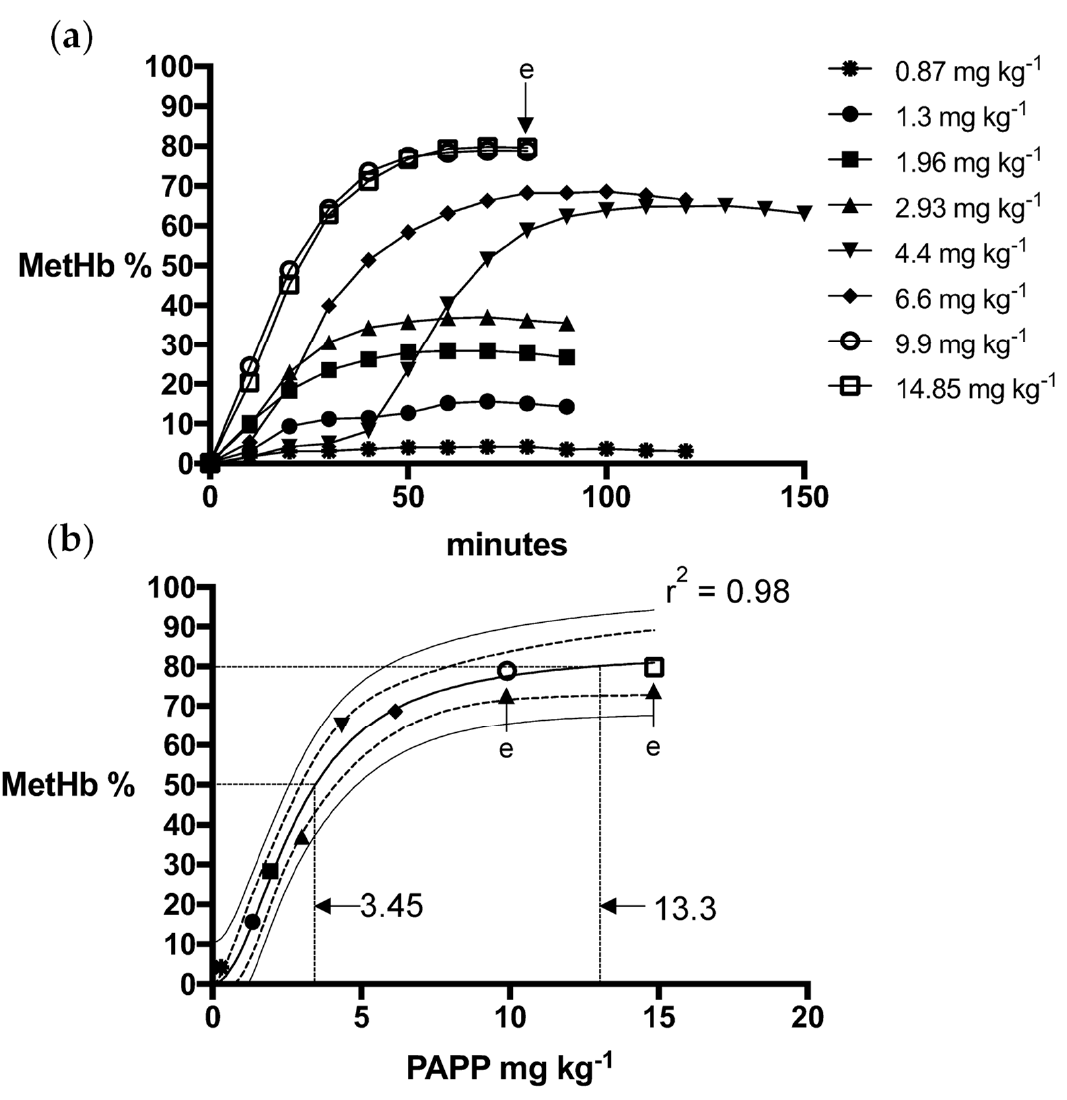
Figure 3. ( a ) Methaemoglobin (MetHb %) response relative to oral dose of PAPP in PEG in foxes and ( b ) the fitted logistics dose-response model for peak MetHb % with 95% confidence (dashed line) and prediction interval (solid line) and when animals were euthanised (e) when they passed the 80% MetHb threshold.